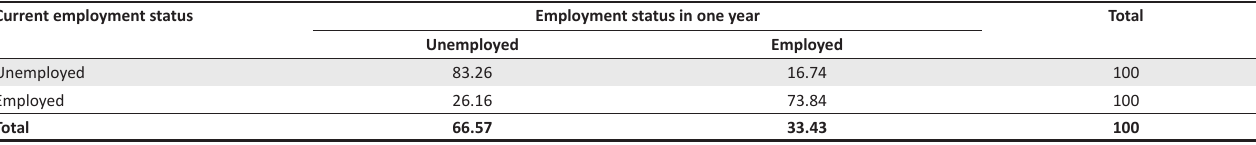
TABLE 5: Employment transition matrix.